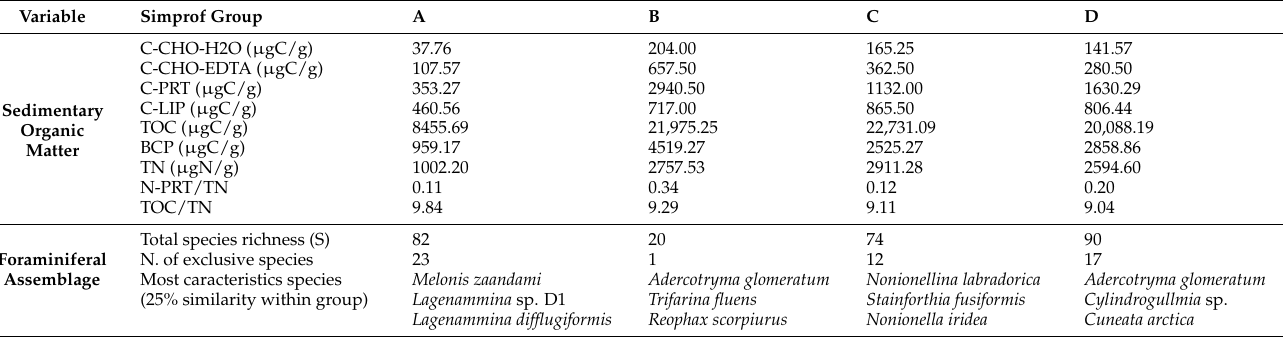
Table 4. Characterization of major sedimentary organic matter variables used for the hierarchical cluster analyses resulting from the SIMPROF analyses; data of foraminiferal biodiversity are